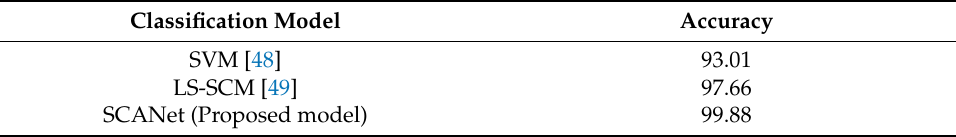
Table 7. Comparison of the classification results using grape leaf diseases